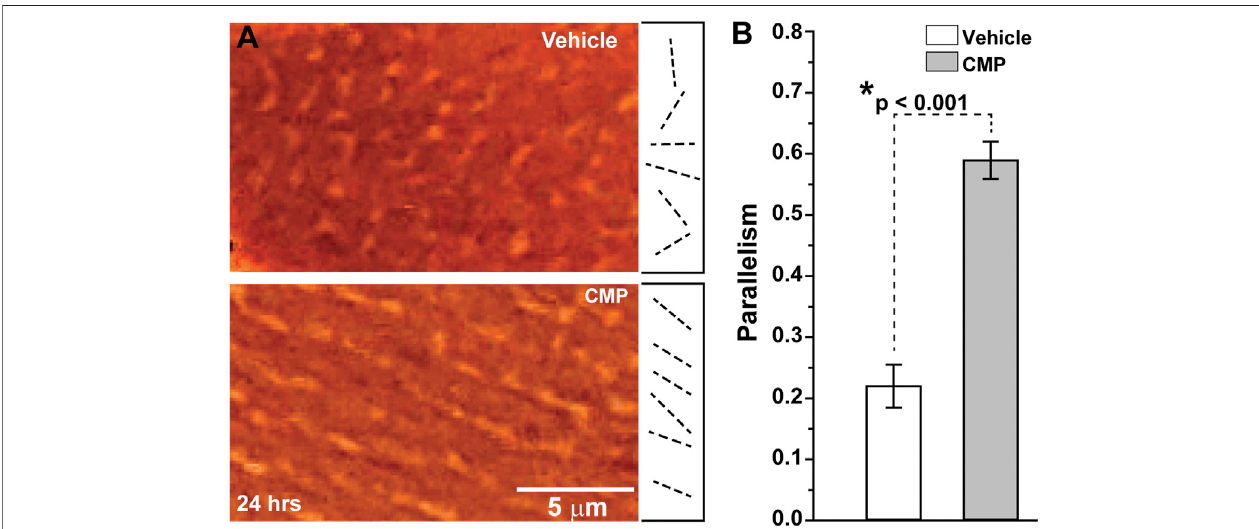
FIGURE 1 | CMP realigns collagen fi bers damaged by collagenase in vitro. (A) Edge-enhanced differential interference contrast images of applied type I collagen damaged by collagenase and treated with a vehicle (top) or CMP (bottom). Example vectors (dashed lines) assigned by algorithm show a higher degree of parallelism in CMP-treatedpreparations. (B) VectorsinpreparationstreatedwithCMPhaveahigheraveragetendencyforparallelalignmentcomparedtoavehicle(*: p < 0.001).Data: mean ± SEM; n (cid:2)